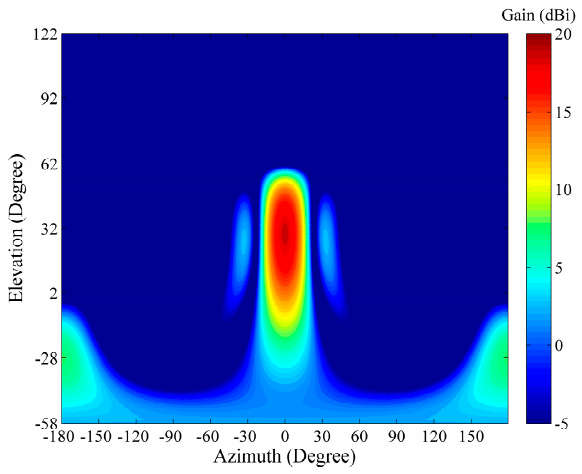
Figure 5. Computed radiation pattern of the antenna array at 10 MHz (main lobe vector alignment), where dBi values are with reference to an isotropic gain pattern.